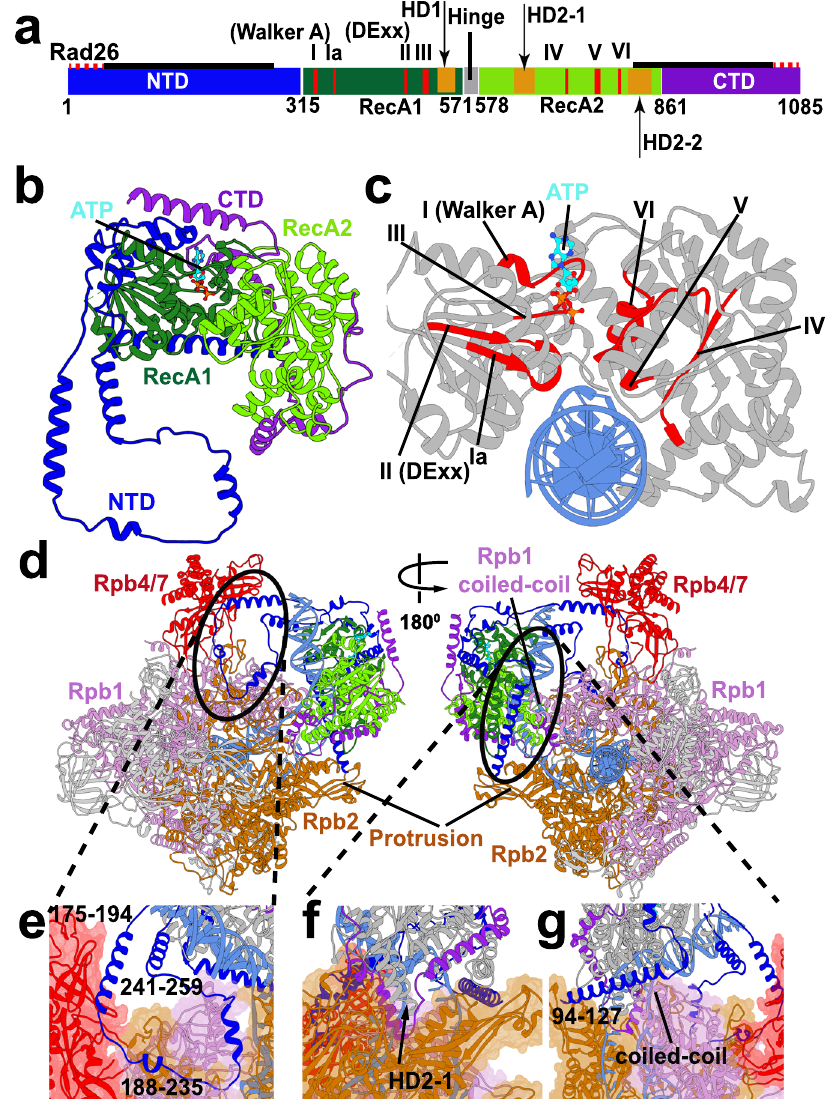
Fig. 1 Cryo-EM based Pol II – Rad26 structural model reveals the critical anchoring roles of the NTD and CTD domains. a Schematic showing the Rad26 protein domains along its sequence. Newly modeled regions are highlighted with solid black lines. Seven canonical SF2 helicase motifs are shown in red bars. The hinge between the two ATPase modules is indicated by a black vertical bar. b View of Rad26 in cartoon representation colored by domains. RecA1 is shown in green, RecA2 in light green, NTD in blue and CTD in purple. c Side view of the Rad26 active site cleft with DNA (blue) and highlighted functional motifs I – VI (red). ATP is shown in stick representation and colored in cyan. d Anterior and posterior views of the Pol II – Rad26 complex. Rpb1, Rpb2 and Rpb4/7 are in light purple, brown and red, respectively. Rad26 is colored by domains. Circles demark zoomed-in regions in panels e-g. e NTD of Rad26 interacting with the Rpb1, Rpb2 and Rpb4/7 subunits of Pol II. f CTD and HD2-1 of Rad26 interacting with Rpb2 and DNA. g NTD of Rad26 interacting with the Rpb1 protrusion and the clamp coiled-coil